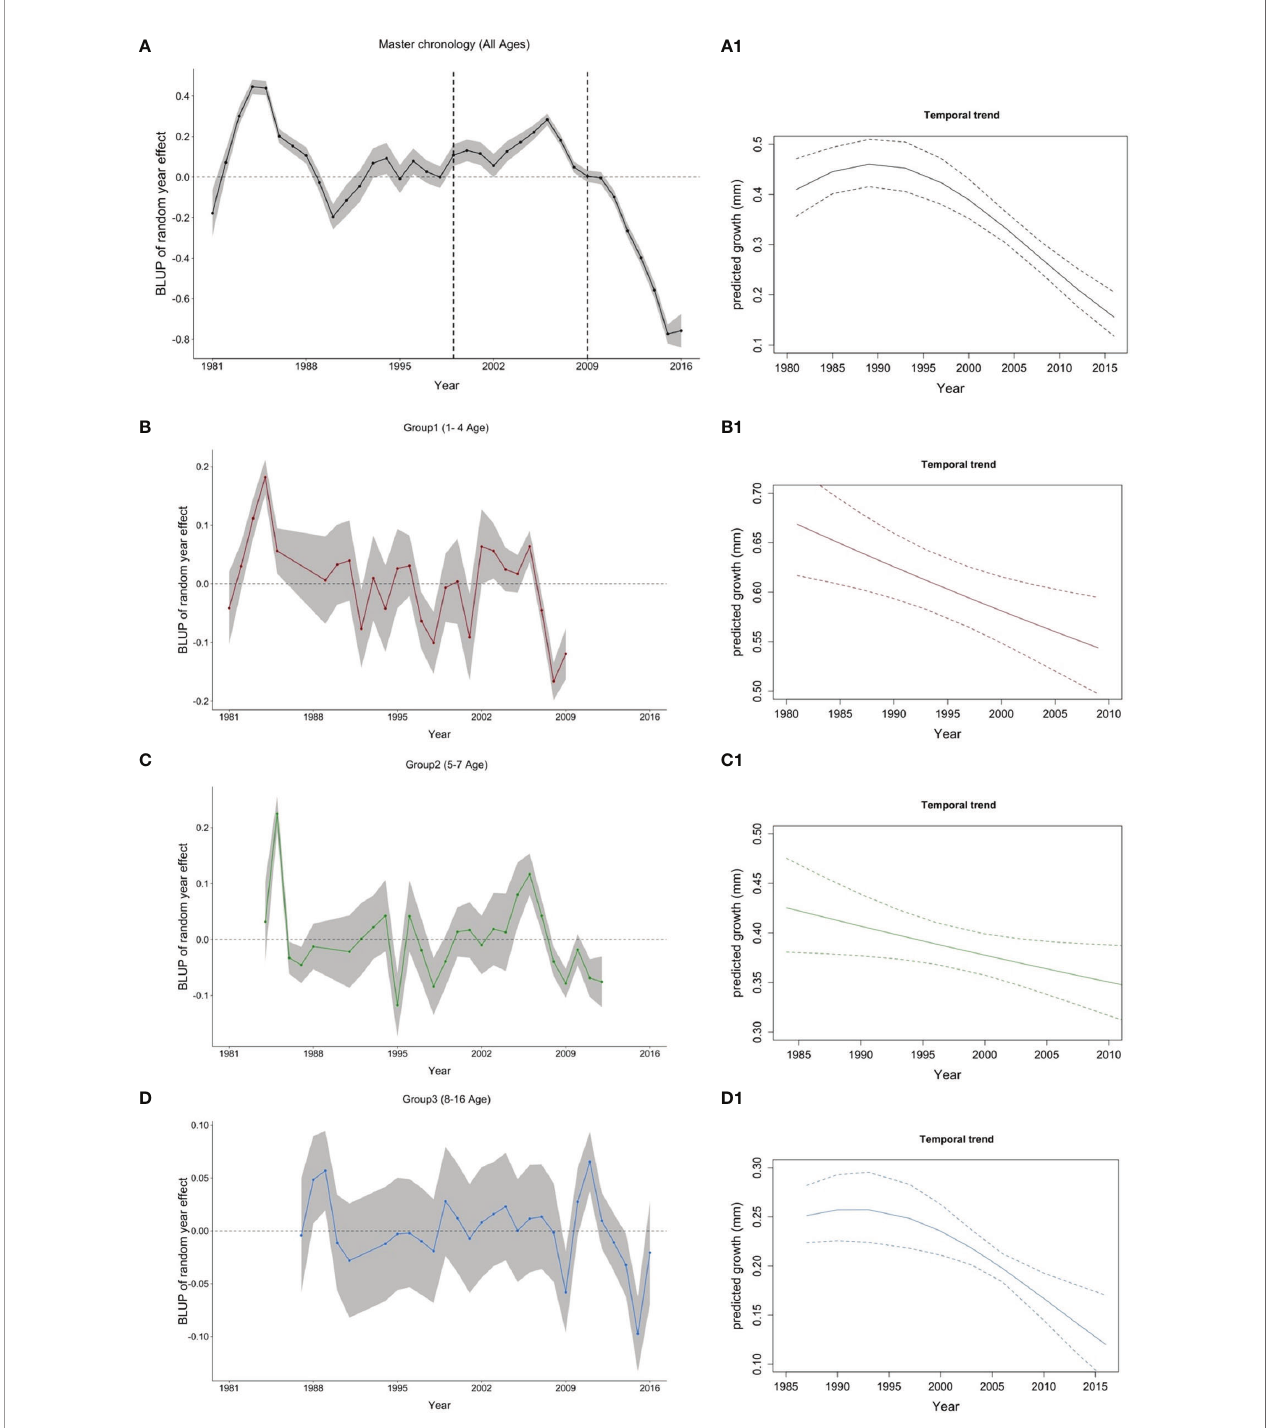
FIGURE 4 | Best linear unbiased predictor (BLUP) for the year random effect (left panel- A ) Master chronology, (B) Group 1, (C) Group 2 and (D) Group 3) and temporal trend of cod growth (right panel — A1) All ages, B1) Group 1, C1) Group 2, and D1) Group 3. Age groups are also indicated by the following colors: All ages (1-16): black; Group 1 (age 1-4): red; Group 2 (age 5-7): green and Group 3 (age >=8): blue. Vertical dashed lines in the master chronology indicate the beginning and the end of the